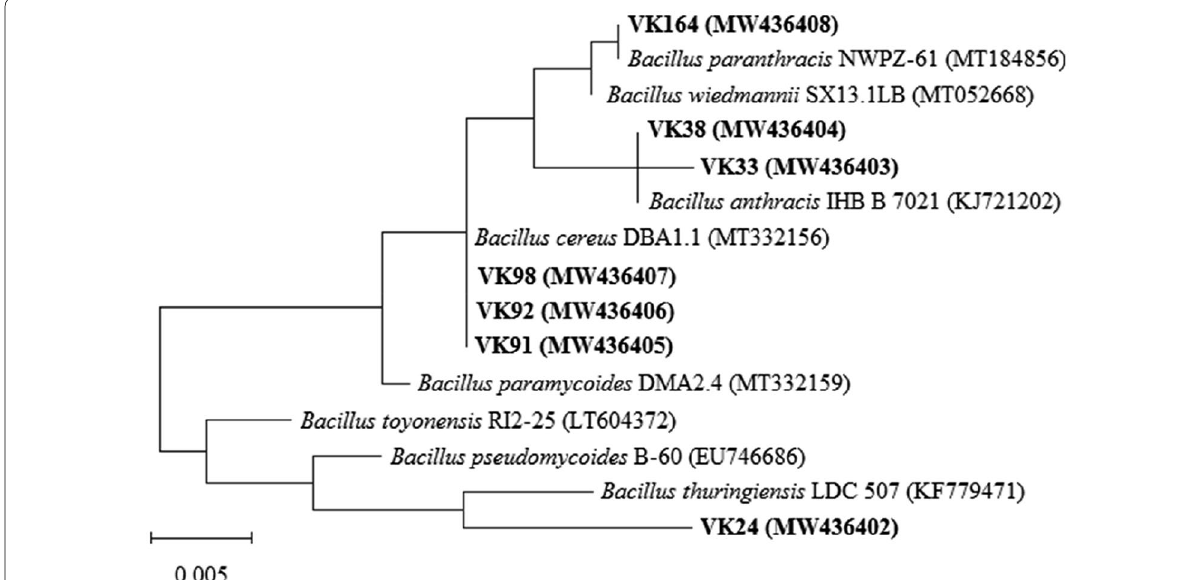
Fig. 1 Maximum likelihood phylogenetic tree based on 16S rRNA gene sequences showing the relationships between the seven selected strains and other strains of the genus Bacillus . Bar 0.05 subtitutions per